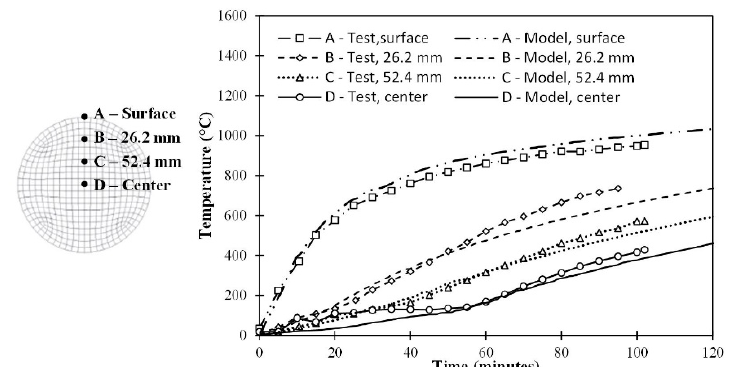
Figure 4. Time-temperature relationships obtained experimentally by Wang and Young [16] and numerically in this paper for column